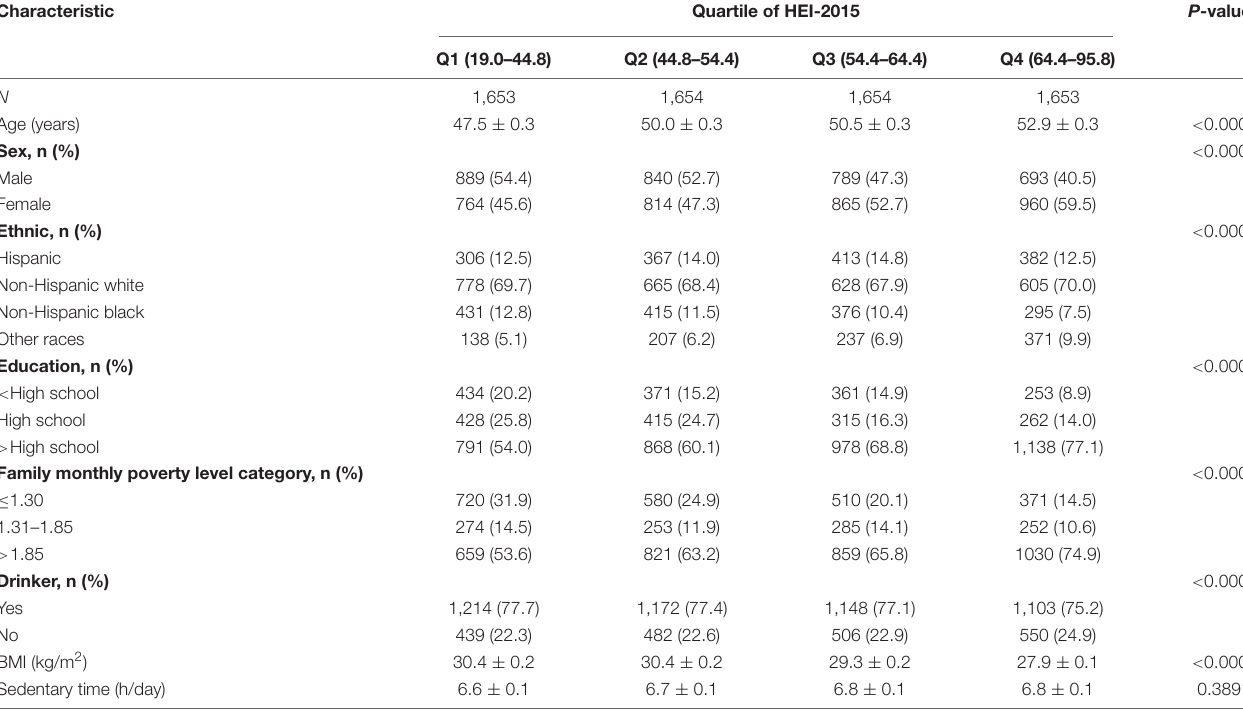
TABLE 1 | Characteristics of study participants according to HEI-2015 quartile (weighted analysis). 1